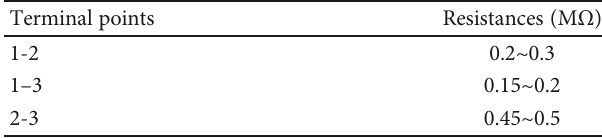
Figure 6: (a) Complete device before etching. (b) Complete device after etching. Table 5: Measured resistance after membrane